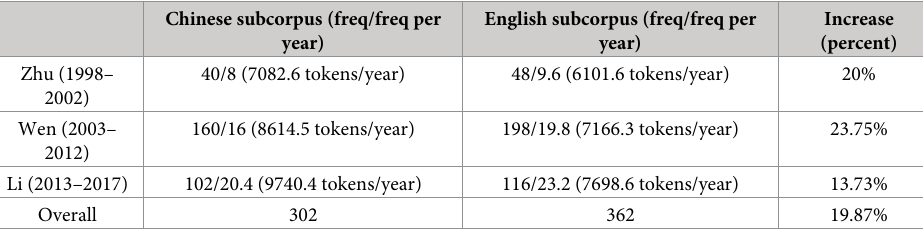
Table 3. Lexical items relating to the world and globe in both subcorpora and diachronically across the